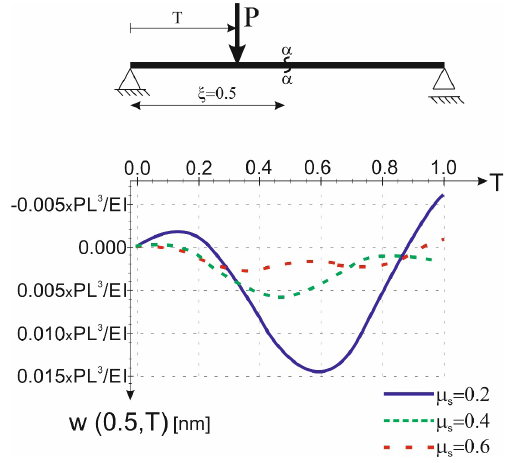
Figure 9: Strain gradient model. Vibrations of the beam in the η = . middle cross section if 0.01 g